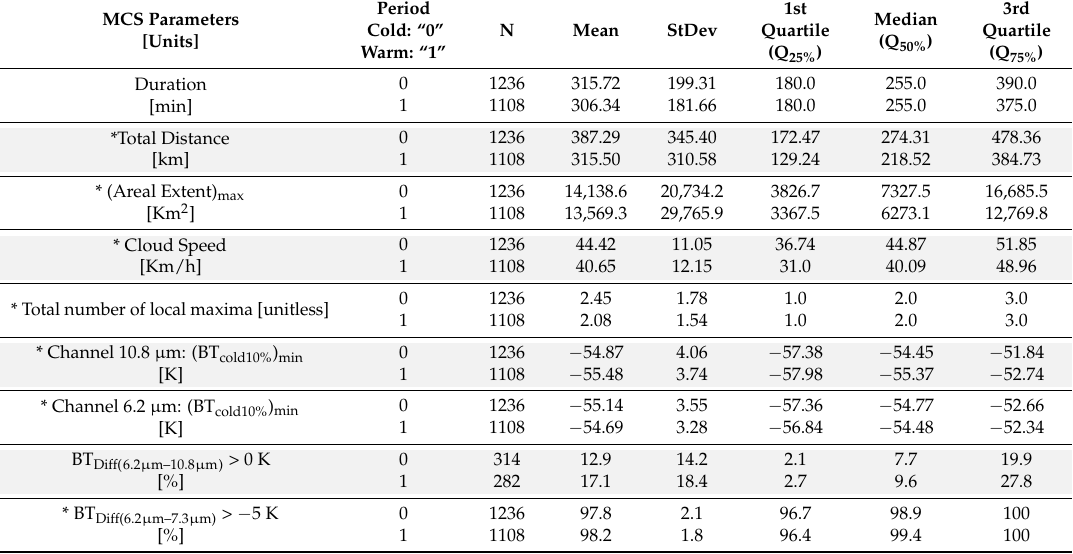
Table 6. Basic descriptive statistics for the number of MCSs with at least one CC localmax event during the cold and the warm season of the year. The values of the parameter “BT Diff(6.2 µ m–10.8 µ m) ” refer only to the number of MCSs where at least one cloud cell during an MCS lifecycle fulfills this criterion “BT Diff(6.2 µ m–10.8 µ m) > 0 K” (596 MCS out of 2344 in total). The asterisk (“*”) represents statistically significant differences of the mean values (95% statistical confidence